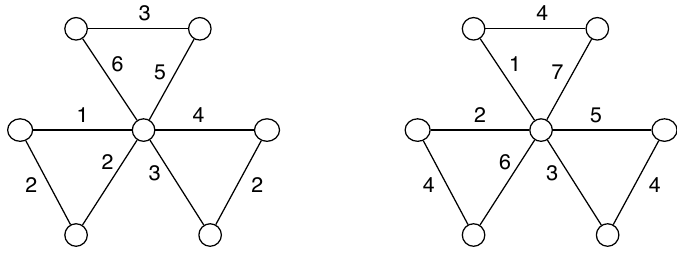
Figure 5: Z -antimagic labelings of F G k